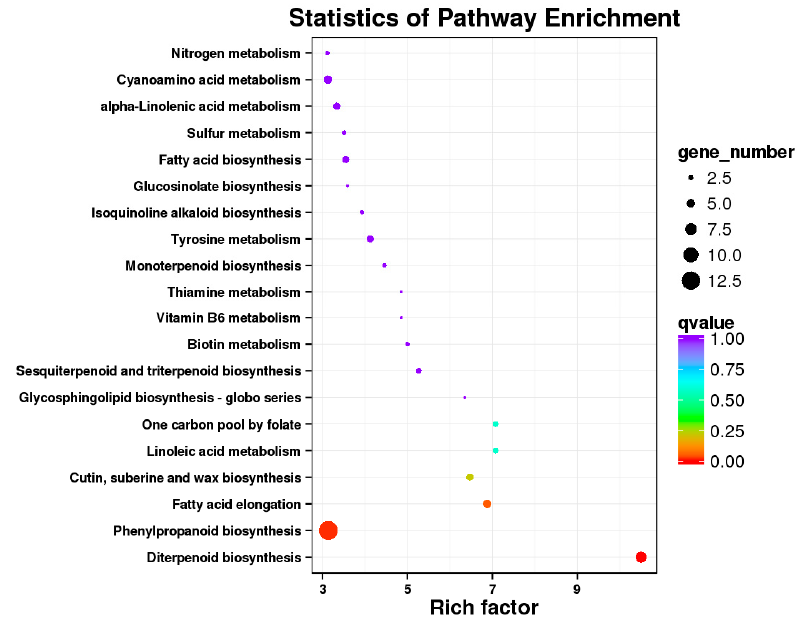
Figure 3. KEGG (Kyoto encyclopedia of genes and genomes, C) pathway enrichment analysis of differentially expressed genes (DEGs) between the two groups (ammonium (A–N) vs. nitrate (N–N)). The x -axis indicates the enrichment factor, while the color of each circle relates to the enriched Q-value and the size is equivalent to the gene numbers mapped to the pathway.